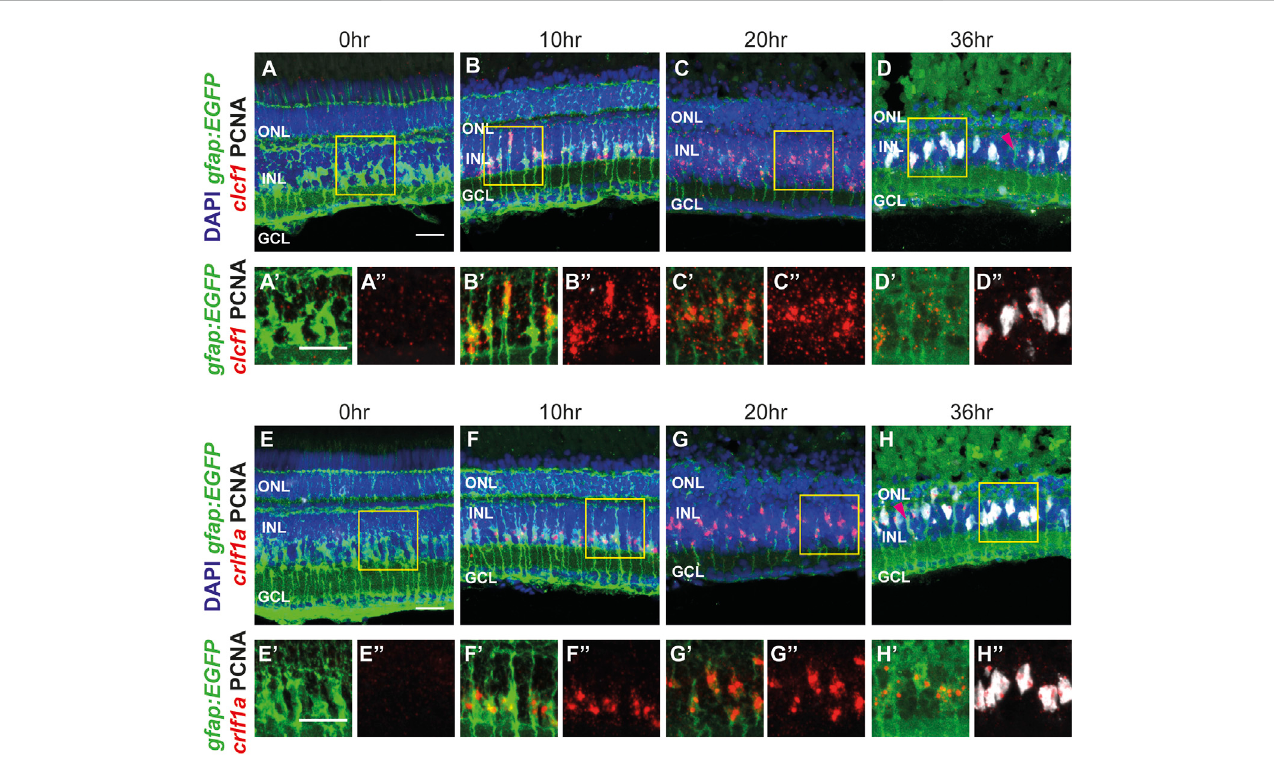
FIGURE 3 The CNTFR ligands clcf1 and crlf1a are detected within Müller glia following injury, consistent with scRNA-seq data. (A – H")Maximum projection images of dark-adapted albino; Tg[gfap:EGFP] nt11 zebra fi sh that were light-treated for up to 36 h, with in situ hybridization performed utilizing either clcf1 (A – D") or crlf1a (E – H") probes. Sections were also labeled for GFP and PCNA to assess proliferating Müller glia and nuclei were counterstained with DAPI. Yellow boxes in (A-H) represent areas chosen for greater magni fi cation (in A'-H' and A"-H"). Magenta arrowheads (D, H) show resting Müller glia. ONL, outer nuclear layer, INL, inner nuclear layer, GCL, ganglion cell layer. Scale bar represents 20